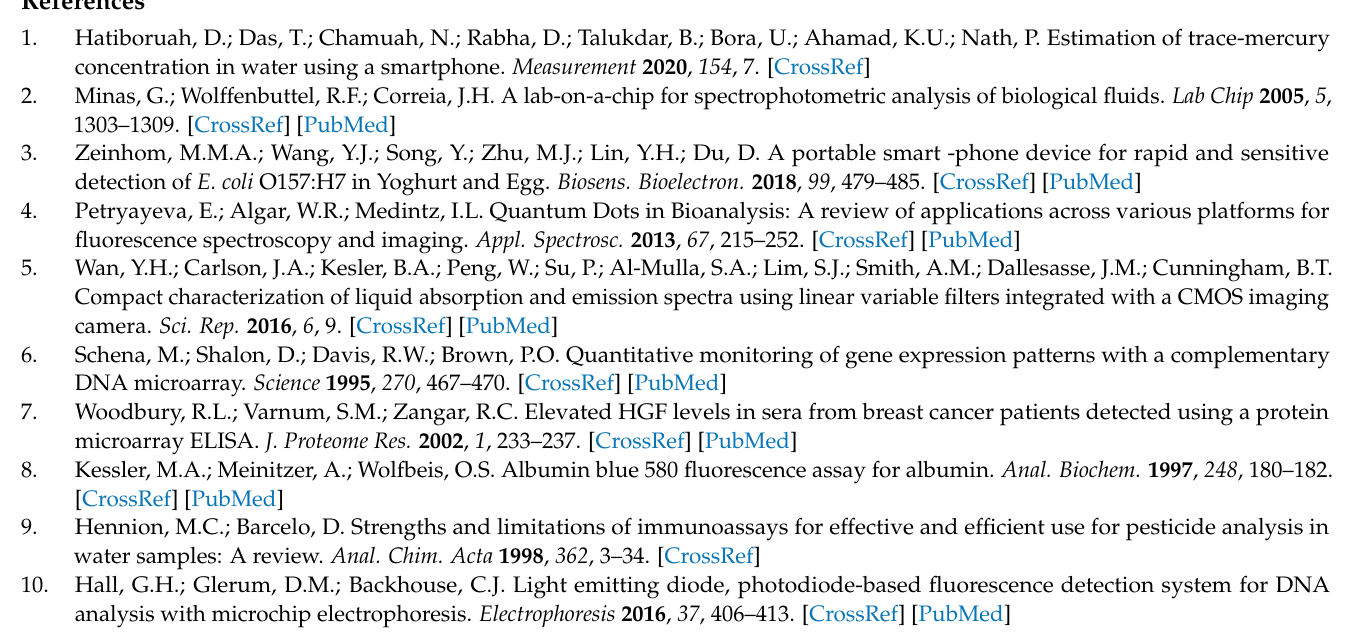
Figure S2: (a) GGP-GMR on top of a CCD. (b) Customized sample chamber with sample inside. (c) Customized sample chamber with lid, Figure S3: Fluorescence emission from different concen- trations of FAM measured using (a) a spectrometer and (b) the proposed GGP-GMR/CCD system, Figure S4: Dose response curve obtained using the (a) GGP-GMR/CCD system and (b) spectrometer. (c) This figure displays the correlation between the normalized intensity of the peak wavelength and that of the MICP, Figure S5: (a) Peak wavelength (blue) and measured MICP (orange) as a function of the concentration. (b) Correlation between the peak wavelength and the MICP, Table S1: Composition of artificial